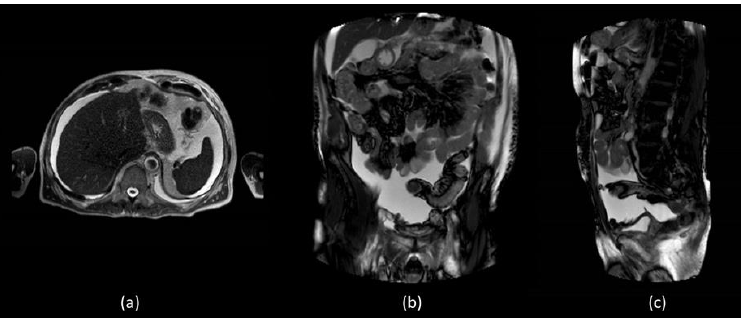
Figure 2. MR T1 weighted ( a ) axial section of the liver did not show diseases but confirmed the presence of massive fluid effusion, visible in the supra and submesocholic space and also in the coronal ( b ) and sagittal images ( c ).